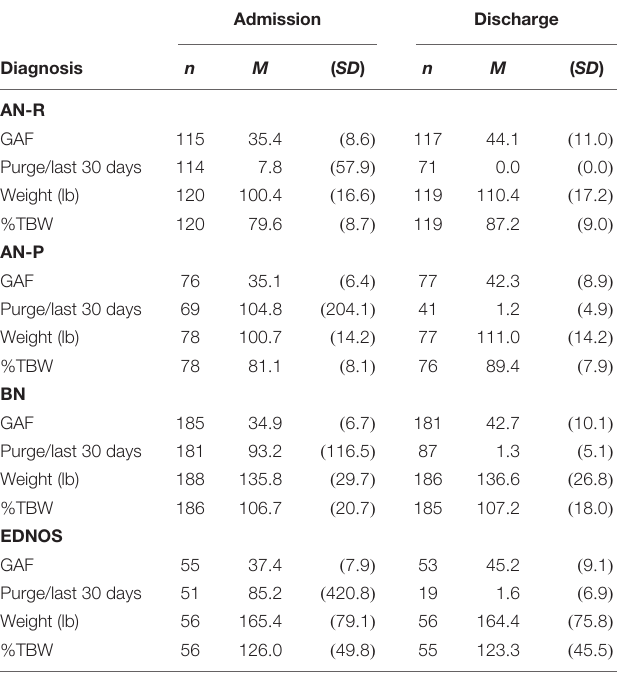
TABLE 3 | Status on admission and discharge of adult ED residential patients by